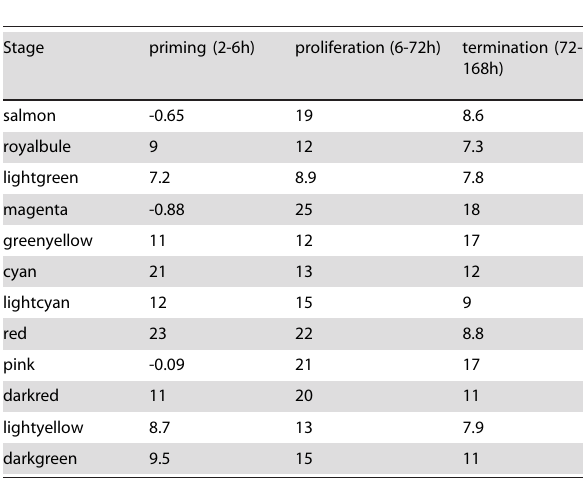
Table 3. Module preservation statistics ( Z summary ) in distinct stages of LR after 2/3